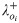
Optimal and approximate interruption thresholds.(A–C) Optimal thresholds θ (symbols) for degree of belief βD(P) as a function of decision cost cd and (fixed) belief level βQ(G). These are shown for (A) feed, (B) assess (in patch), and (C) assess (in refuge). The lines show a linear approximation to the thresholds. (D–F) Optimal and approximate thresholds for the same activities as a function of cd and cue reliability (i.e., higher or lower true positive rate for indirect observations, λoi+, or direct observations, λod+); βQ(G) = 0.5. Unless otherwise indicated, the default reliabilities were λoi-=0.1, λoi+=0.5, λod-=0.1, λod=0.9. Other parameters as previous.